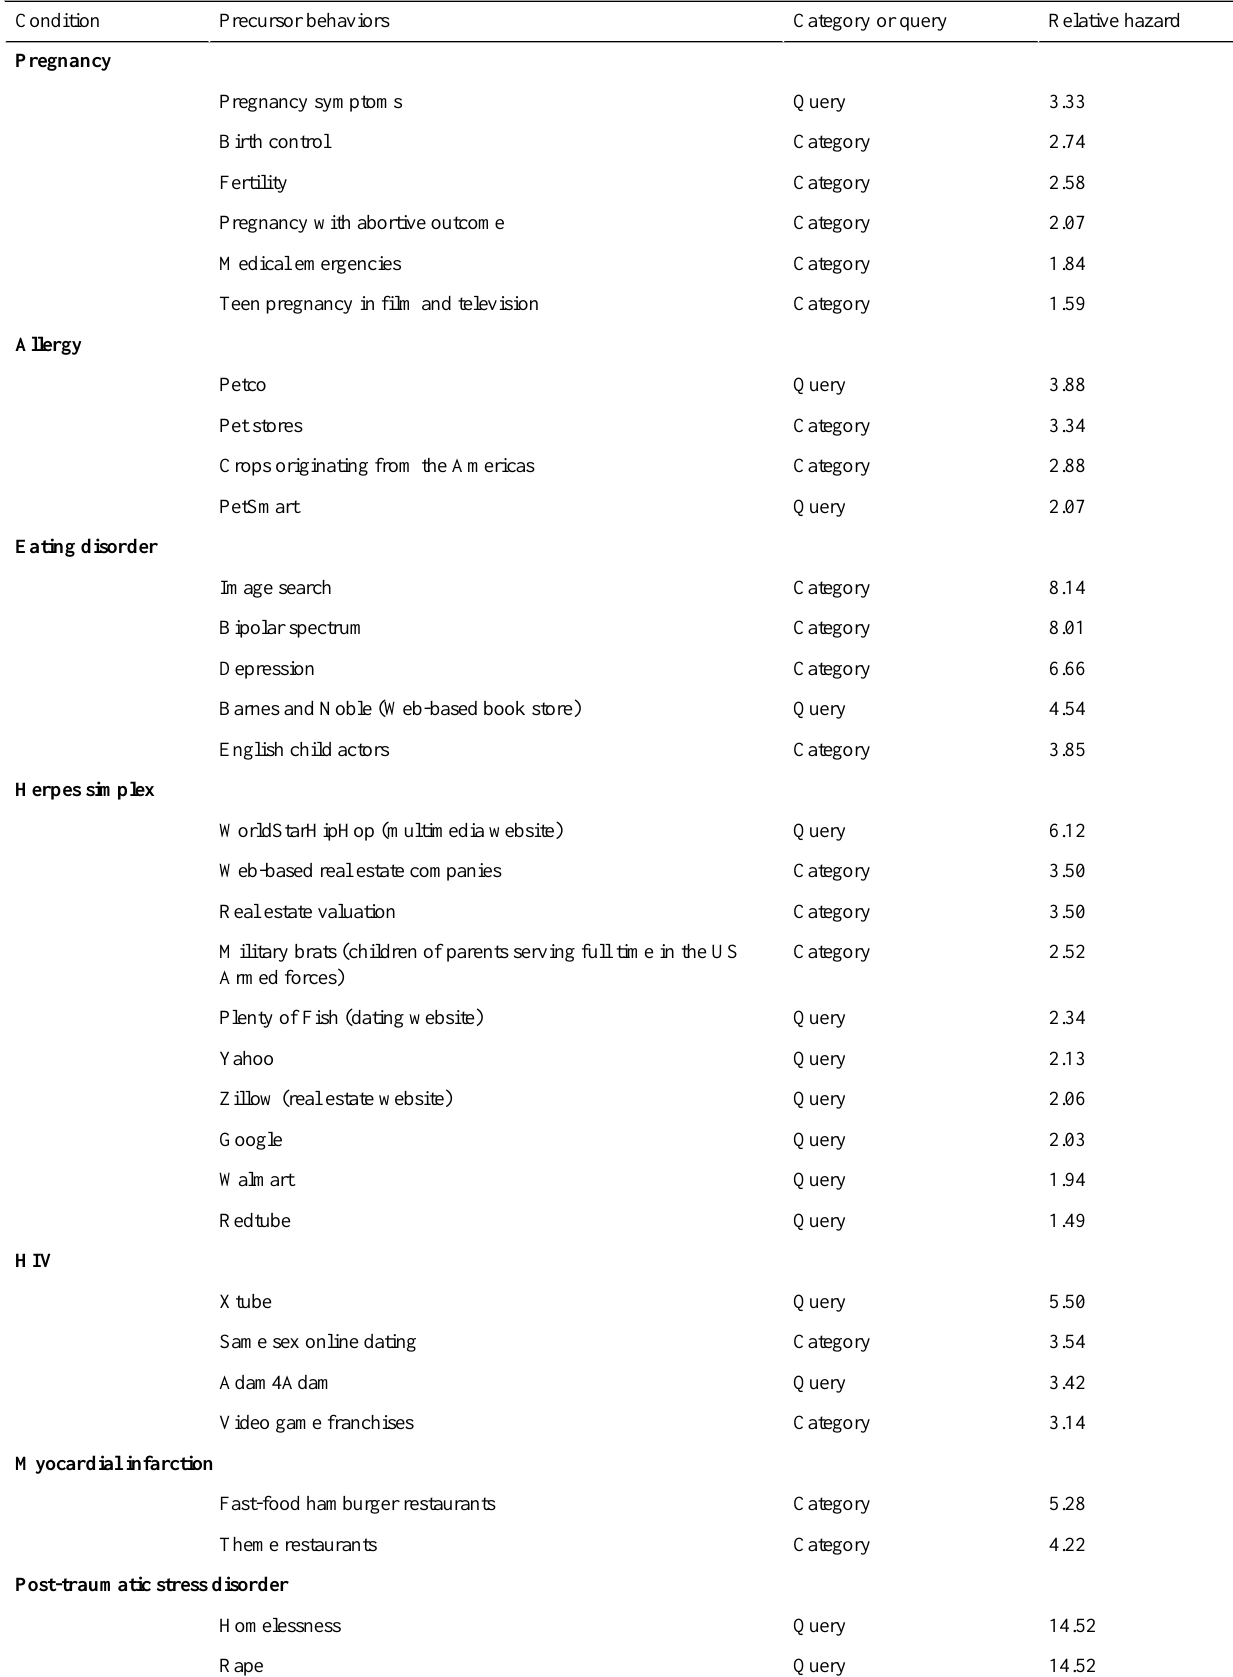
Table 6. Precursor search categories and queries associated with the analyzed medical conditions (at FDR rate of 0.05). Queries related to interest in specific people afflicted with the medical condition were manually removed from the